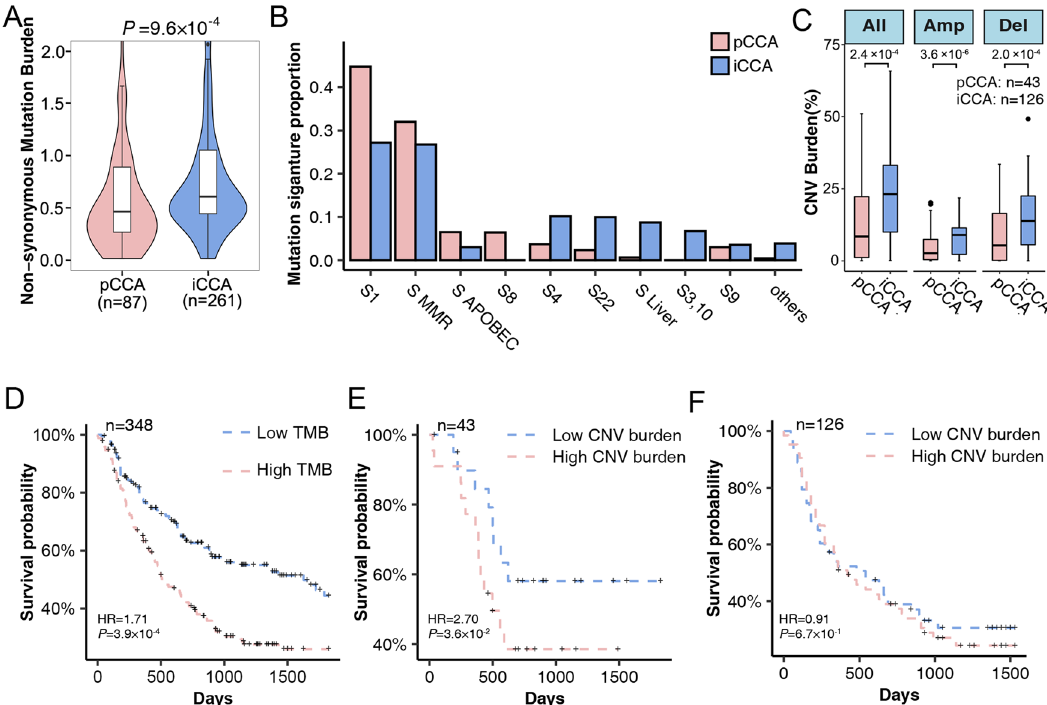
Fig. 1 Mutational spectrum of patients with CCA. A The tumor mutation burden (TMB) of nonsynonymous mutations (substitutions and indels) between pCCAs (presented in red) and iCCAs (presented in blue). P value was obtained from Wilcoxon rank-sum test. B Summary composition of COSMIC 30 mutation signatures in pCCAs (red) and iCCAs (blue). COSMIC Signature MMR included signatures 6, 15, and 26; Signature liver included signatures 12, 16, and 24; Signature APOBEC included signatures 2 and 13. C Difference of copy number alterations burden (CNAB) no matter ampli fi cation or deletion between pCCAs (red) and iCCAs (blue). Wilcoxon rank-sum test was performed to determine the P value. Box plots depicted the median, quartiles and range. The whiskers in box plots extended to the most extreme data point which is no more than 1.5 times IQR. Outliers were identi fi ed using upper/lower quartile ±1.5 times IQR. D Cox proportional hazard model adjusted for age, gender, and stage was conducted to obtain HR and P value ( n = 348). E , F Prognostic effect of CNAB in all samples. E CNAB in 43 pCCAs. F CNAB in 126 iCCAs. * P < 0.05; ** P < 0.01, *** P < 0.001; TMB Tumor mutation burden, CNV Copy number variation, Amp Ampli fi cation, Del